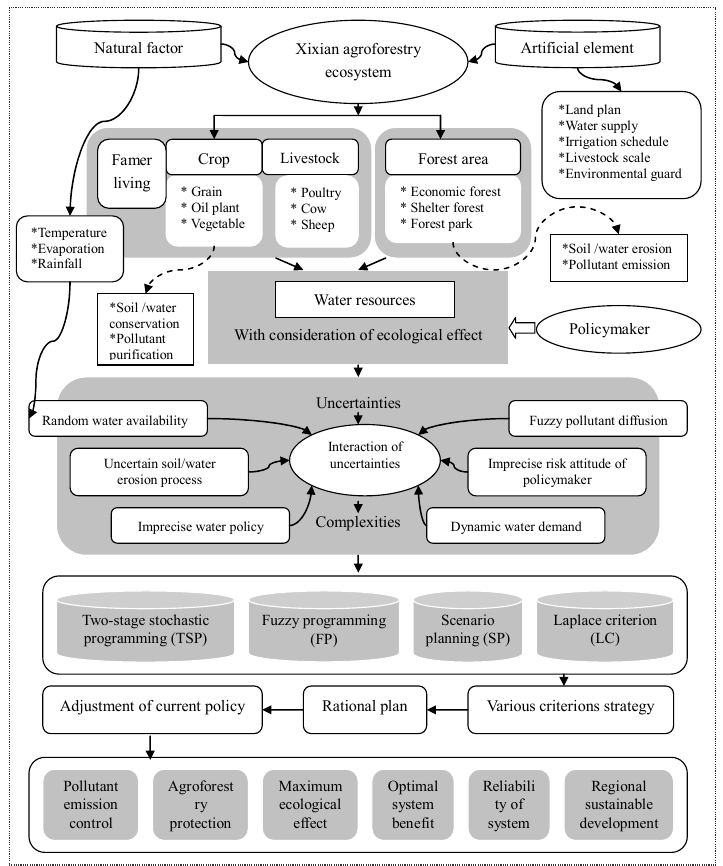
Figure 1. Framework of a fuzzy stochastic programming with Laplace scenario analysis (FSL) in agroforestry ecosystem project (AEP).